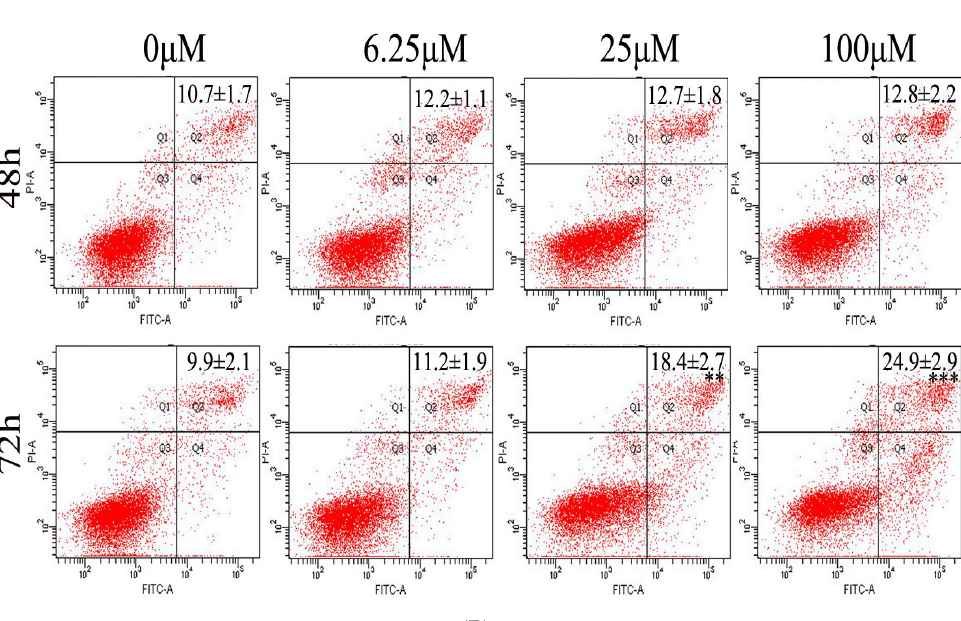
Figure 2. Effects of luteoloside on cell apoptosis. Hela ( A ) and HUVEC12 ( B ) cells were treated with 0, 6.25, 25, and 100 μM luteoloside for 48 or 72 h. The cells were then harvested and stained with annexinV-fluorescein isothiocyanate (FITC) and propidium iodide (PI), followed by flow cytometric analysis. The data are the percentages of apoptosis cells (upper plus lower right quadrants), expressed as the mean ± SD of three independent experiments. * p < 0.05, ** p < 0.01 and *** p < 0.001, versus the control group (0 μM luteoloside).